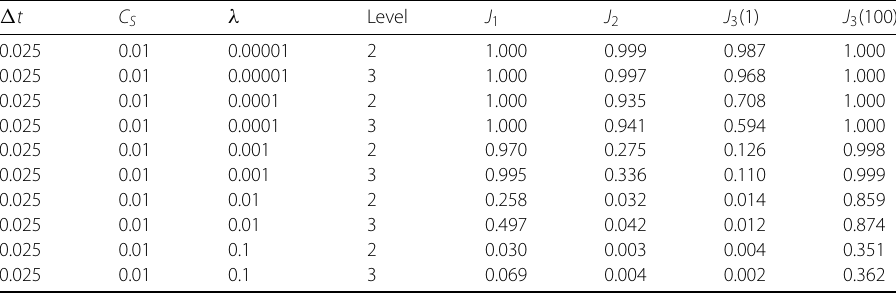
Table 3 Optimization of gas flow rates. Reductions of the objective functionals, level 2 vs. level 3 (cid:18)